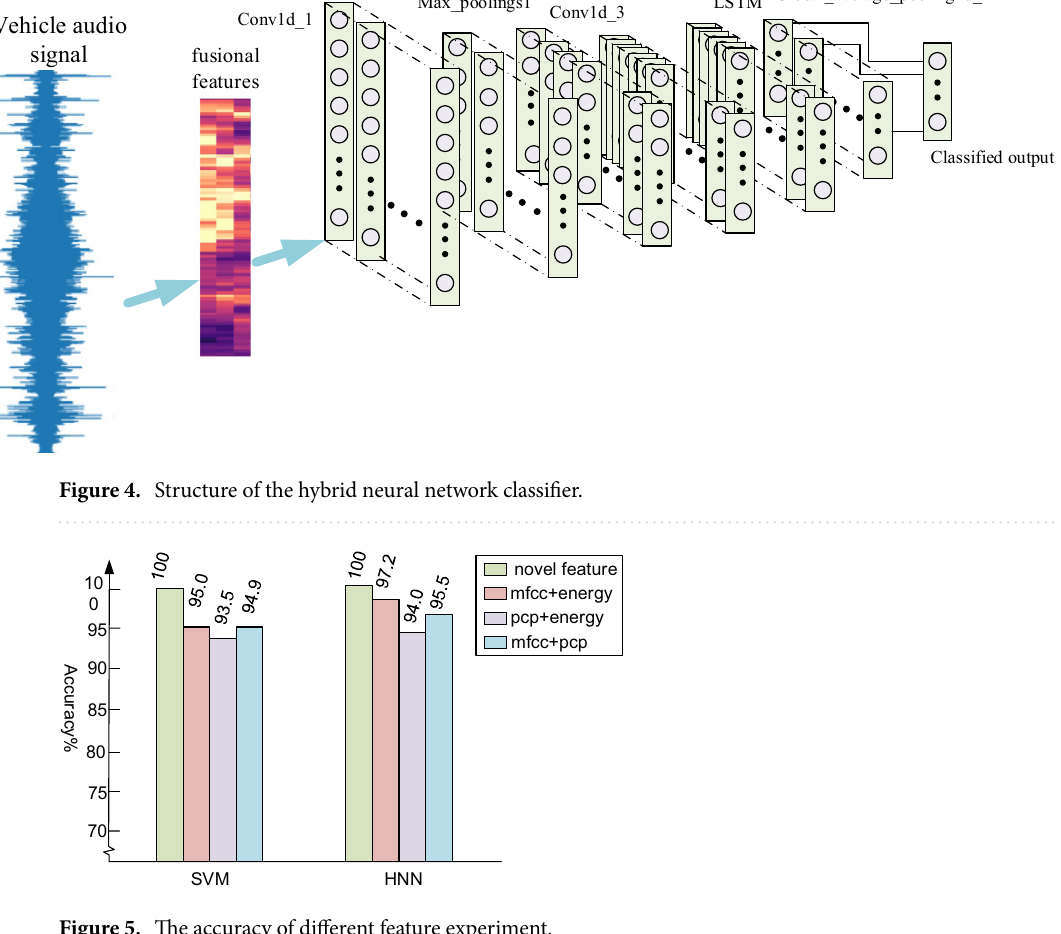
Figure 5. The accuracy of different feature